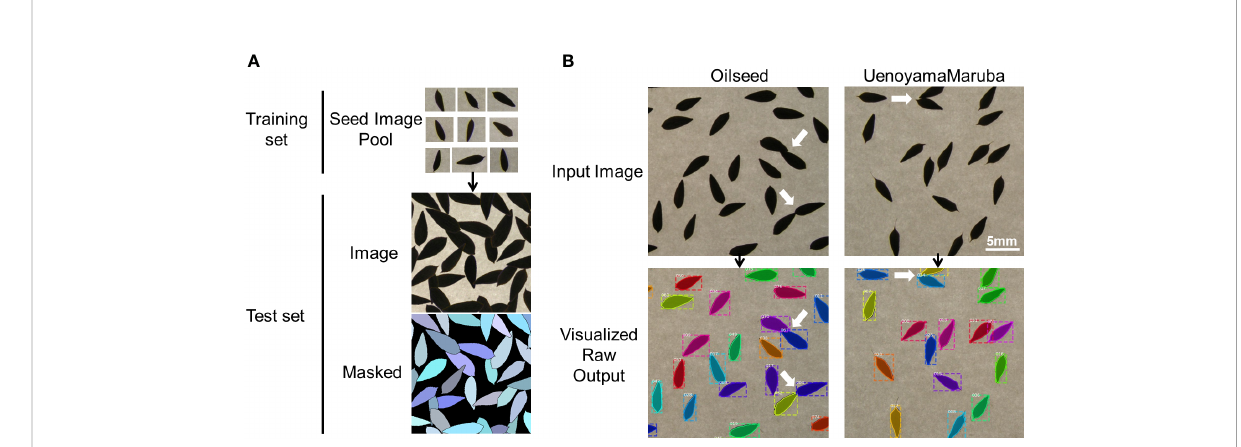
FIGURE 1 Overview of the image analysis pipeline using lettuce seeds. (A) Training pool with individual seed images to identify seeds and measure seed morphology traits. (B) Representative analyses of input images for the two parental cultivars. White arrows indicate overlapping seeds that are recognized as individual seeds by the image analysis